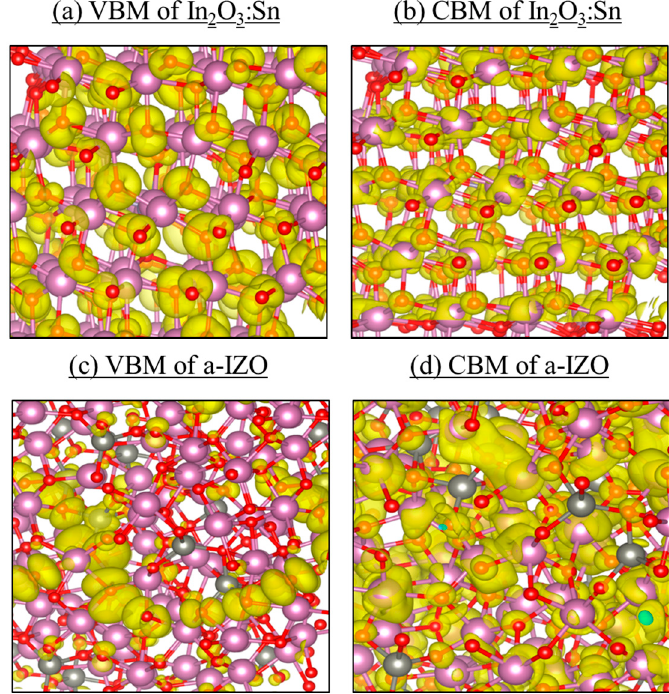
Figure 2. Atomic structure and electron densities of the band edges of polycrystalline In − Sn − O (c ‐ ITO) and disordered amorphous In − Zn − O (a ‐ IZO) generated by molecular dynamics simulation ( a ) valence band maximum (VBM), ( b ) conduction band minimum (CBM) of c ‐ ITO, ( c ) VBM and ( d ) CBM of a ‐ IZO. Except VBM of a ‐ IZO, all wave ‐ functions are well ‐ delocalized. The pink and red balls represent In and O atoms, respectively, and grey balls represent the Sn atom in ( a , b ), and Zn in ( c , d ). The isosurface was selected at 0.0003 e/supercell.